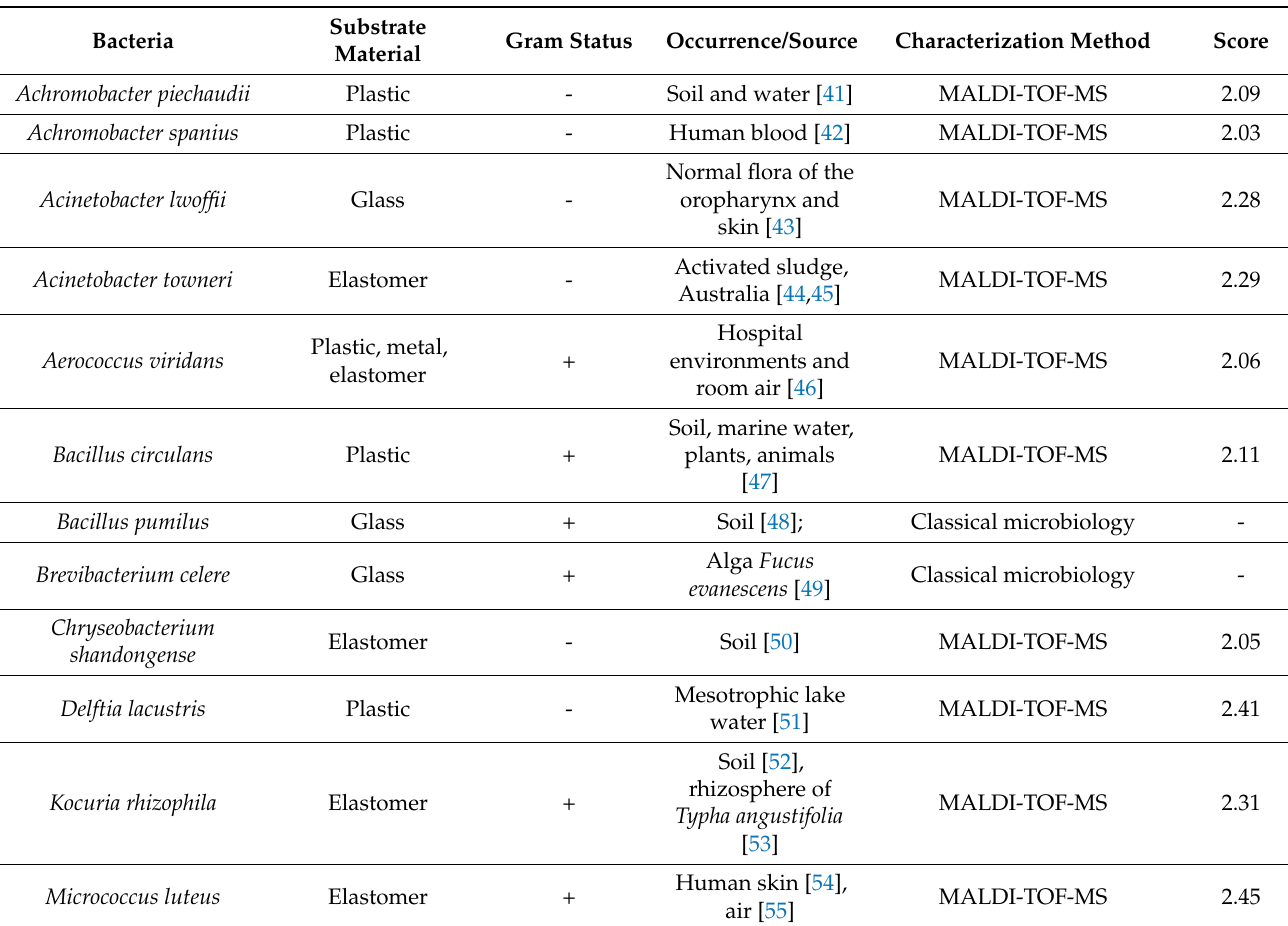
Table 1. List of bacteria isolated from different material surfaces (material category), including gram status, most likely source, and characterization method used for